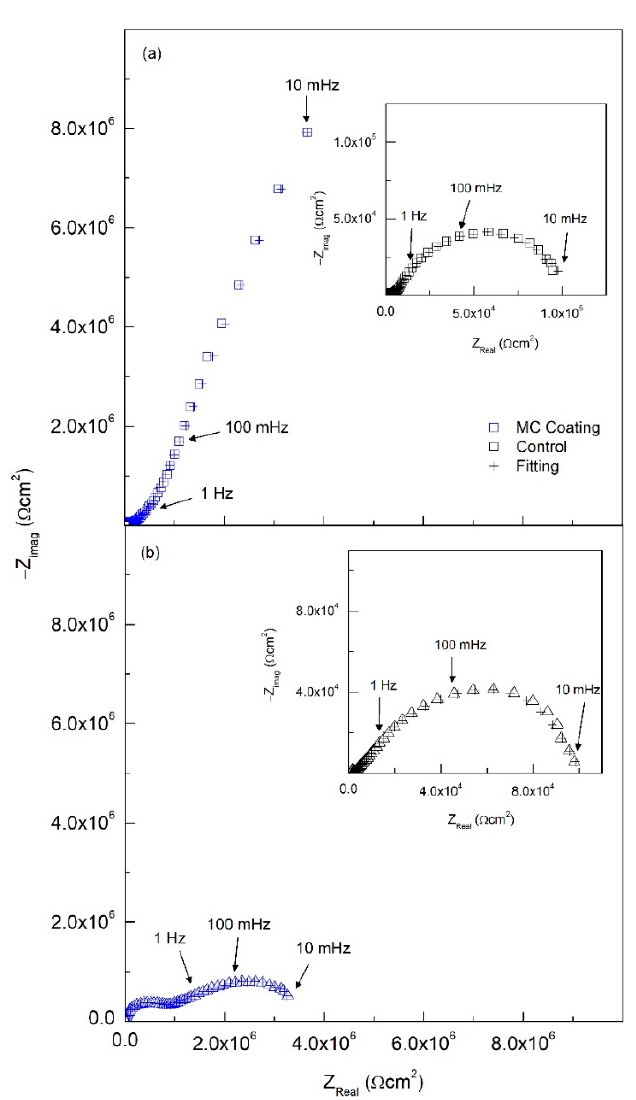
Figure 8. Nyquist plots obtained from EIS for mild steel with epoxy coating modified with colophony microcapsules exposed to ( a ) simulated concrete pore solution, and ( b ) DI water contaminated with 3.5 wt.% NaCl.